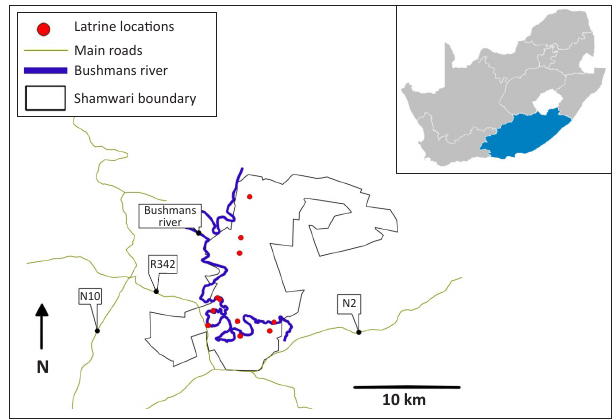
FIGURE 2: Locations of brown hyaena latrines used for faecal scat collection in Shamwari Game Reserve, Eastern Cape Province during the study period, from April 2008 to June